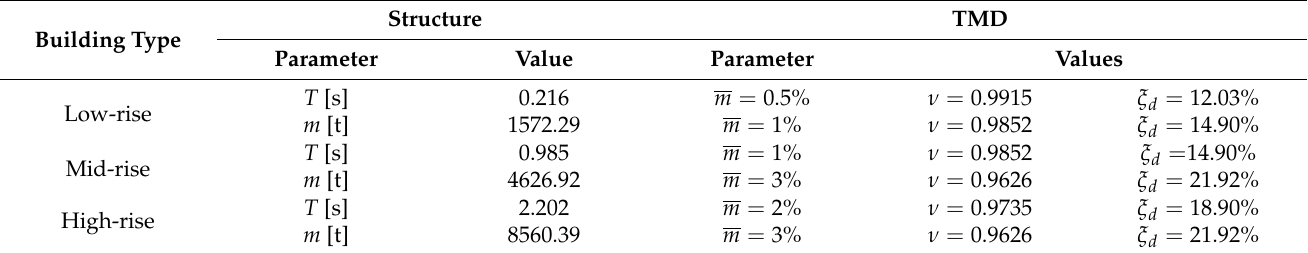
Table 3. Structure-TMD optimal parameter